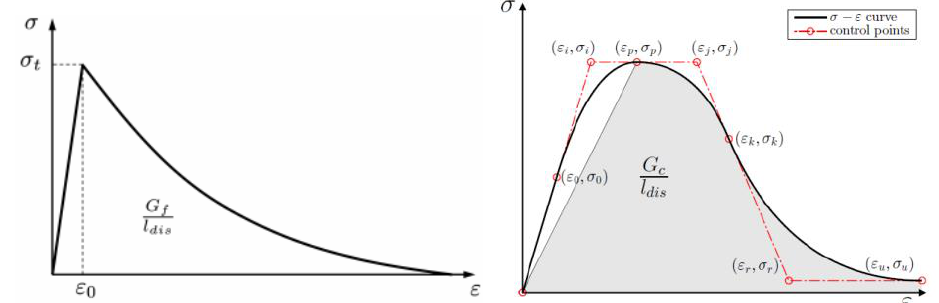
Figure 13. Tensile and compressive uniaxial law of Damage TC3D material model [55].